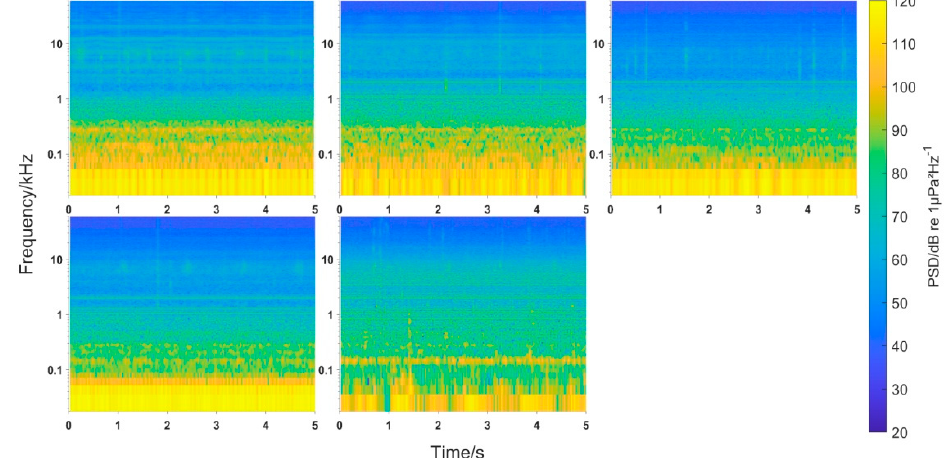
Figure 3. Power spectral densities of all sampling points (first row: S1, S2, S3; second row: S4, Z1; frequency range 20 Hz − 60 kHz).